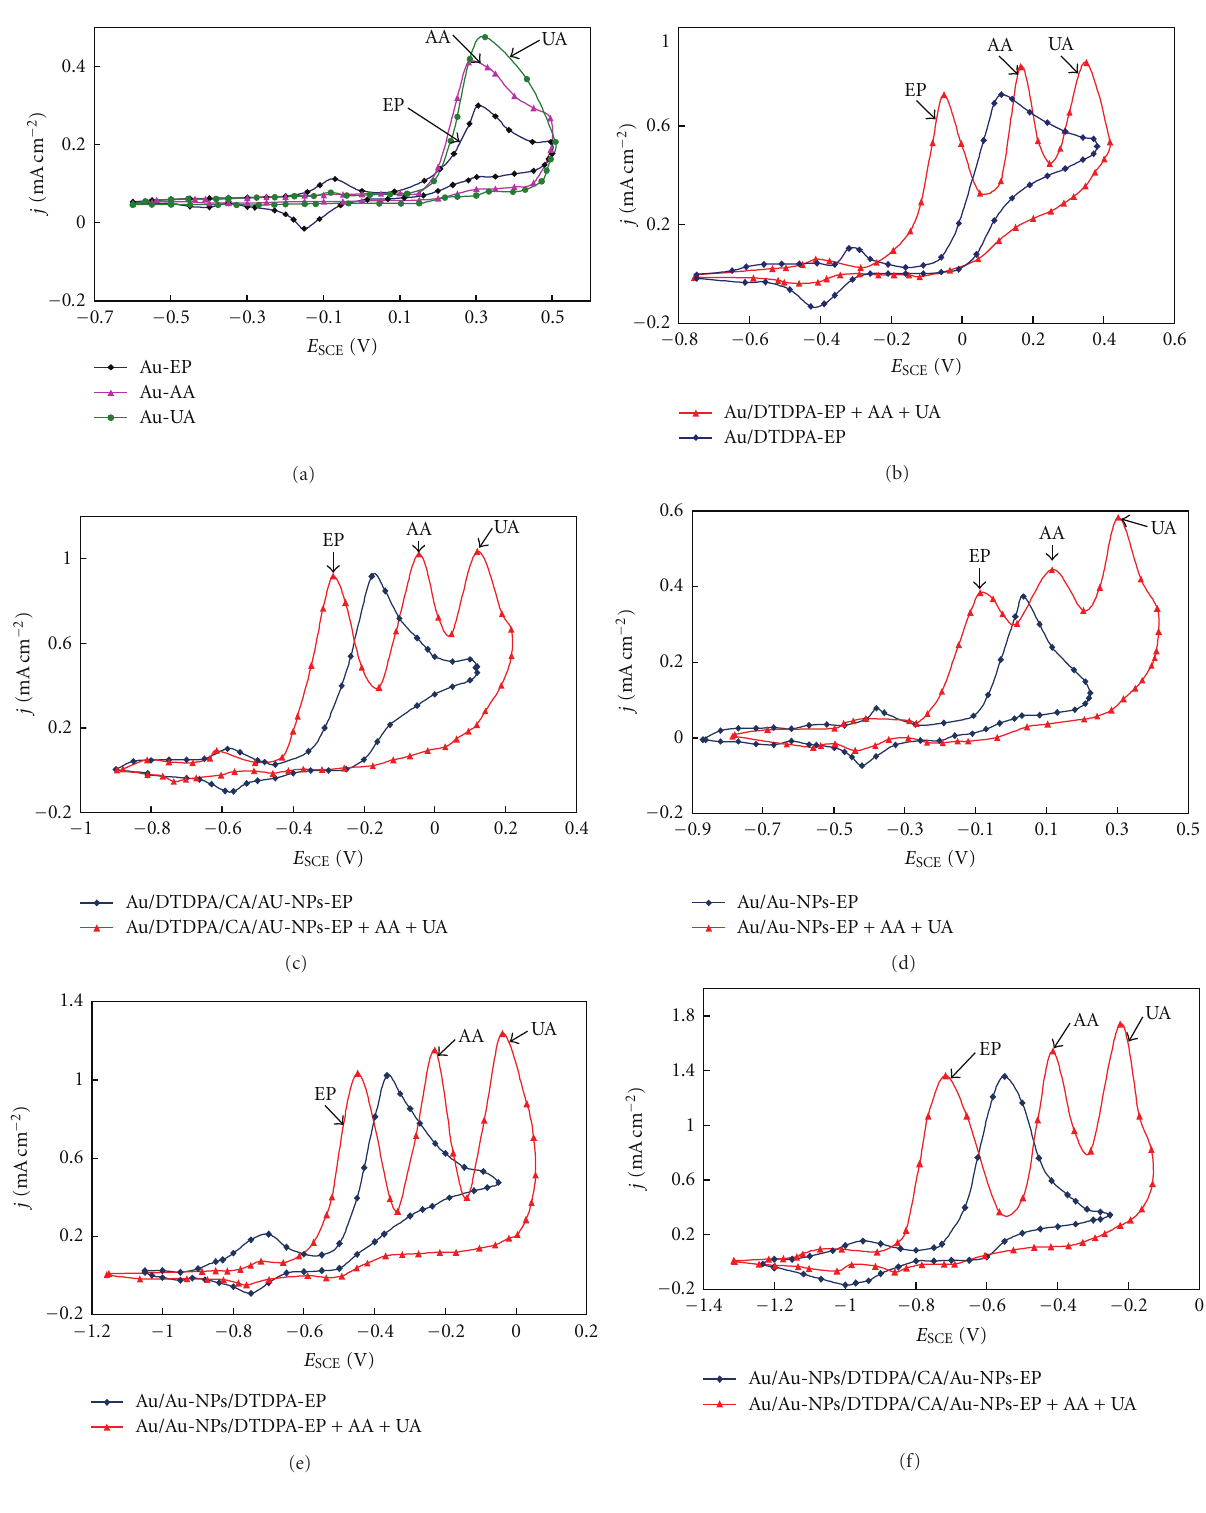
Figure 5: Cyclic voltammograms of pure (a) and modified gold electrodes (b–f) in 60 mM phosphate bu ff er, pH = 7 in a mixture of 500 µ M EP+1000 µ M of AA + 1000 µ M UA. For comparison, each figure presents the cyclic voltammograms in 60 mM phosphate bu ff er, pH = 7 with 500 µ M EP alone for a respective electrode. v = 0 . 1Vs − 1